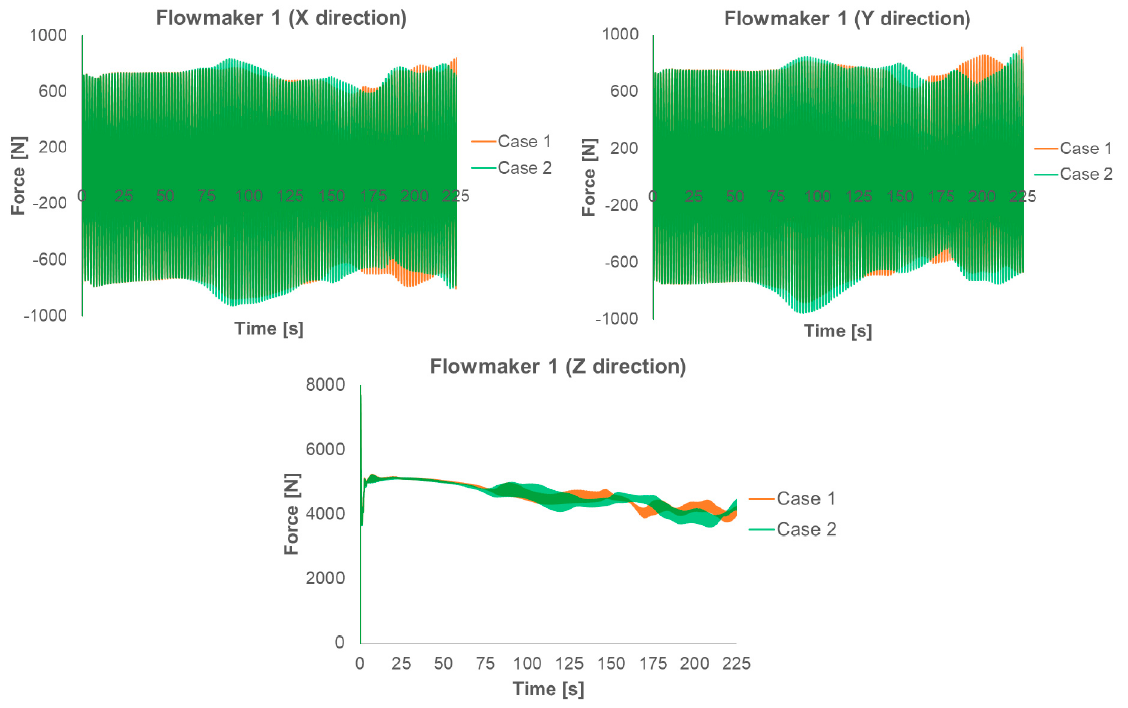
Figure 12. Normal force plots of flowmaker 1 for Case 1 (orange) and Case 2 (green).